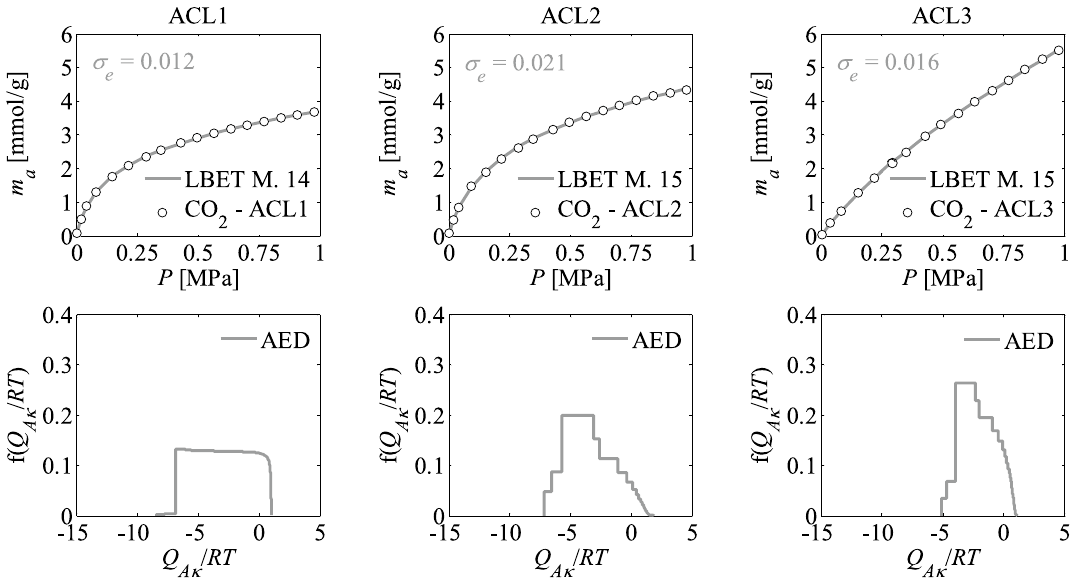
Figure 5. Carbon dioxide adsorption isotherms and adsorption energy distributions (AED) obtained by applying the LBET method to the experimental data for the activated carbons developed by chemical activation of Pine cones with KOH, at the lowest temperature (ACL R ) with the different impregnations ratios ( R = 1, 2,